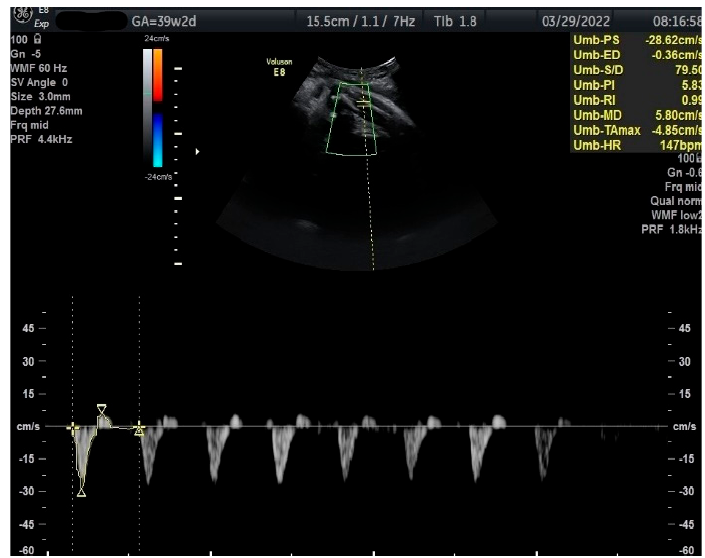
Figure 3. Doppler measurement at 39 + 2 weeks of TA-PI shows reverse flow >95th percentile (measured manually).